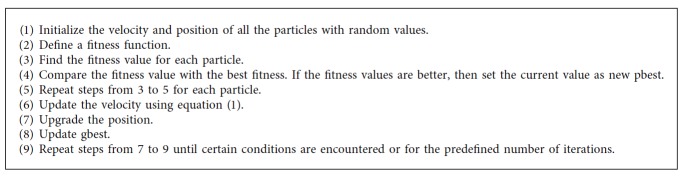
Particle swarm optimization [11, 13].